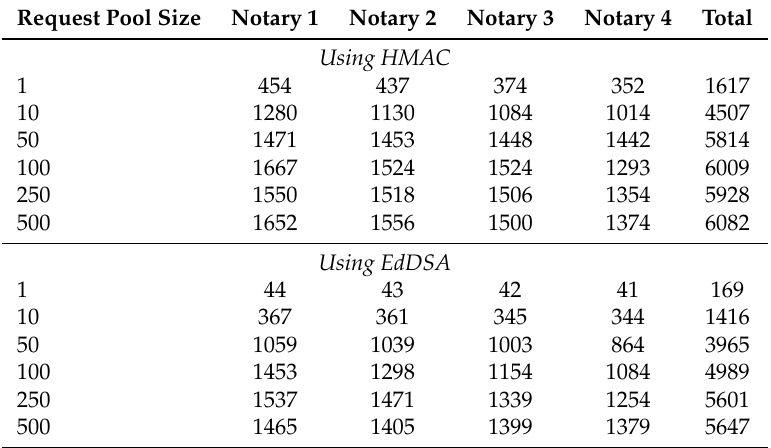
Table 1. The benchmark result of the Core Engine throughput (in requests per second) with a variation of Request Pool size.